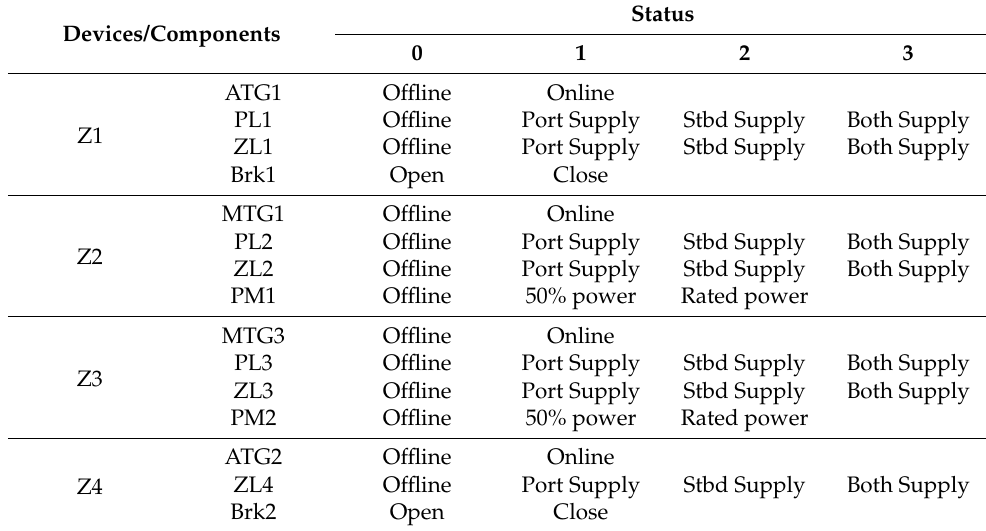
Table 2. Discrete status of components in benchmark